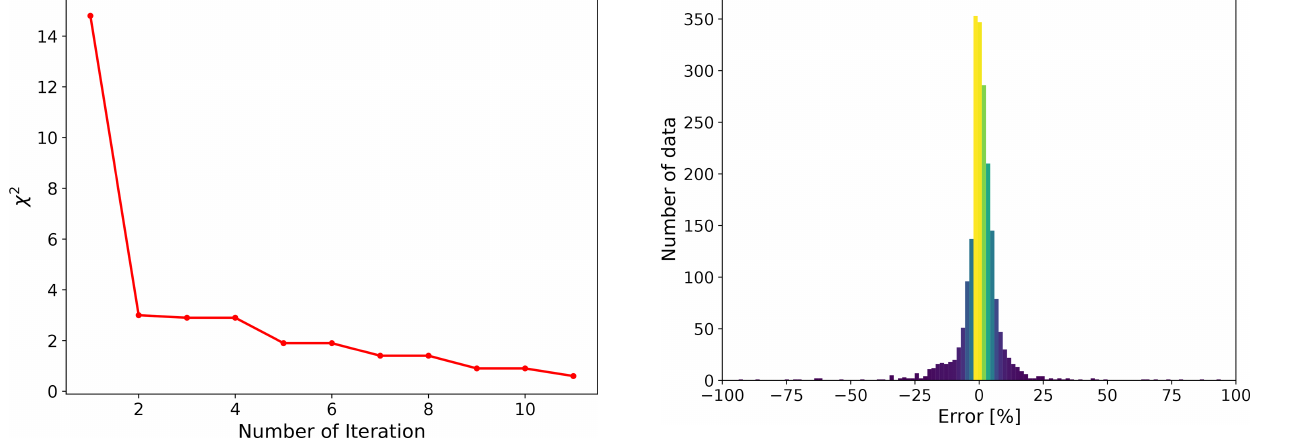
Figure 8. A measure of data misfit as the inversion progresses: χ 2 versus number of iteration.